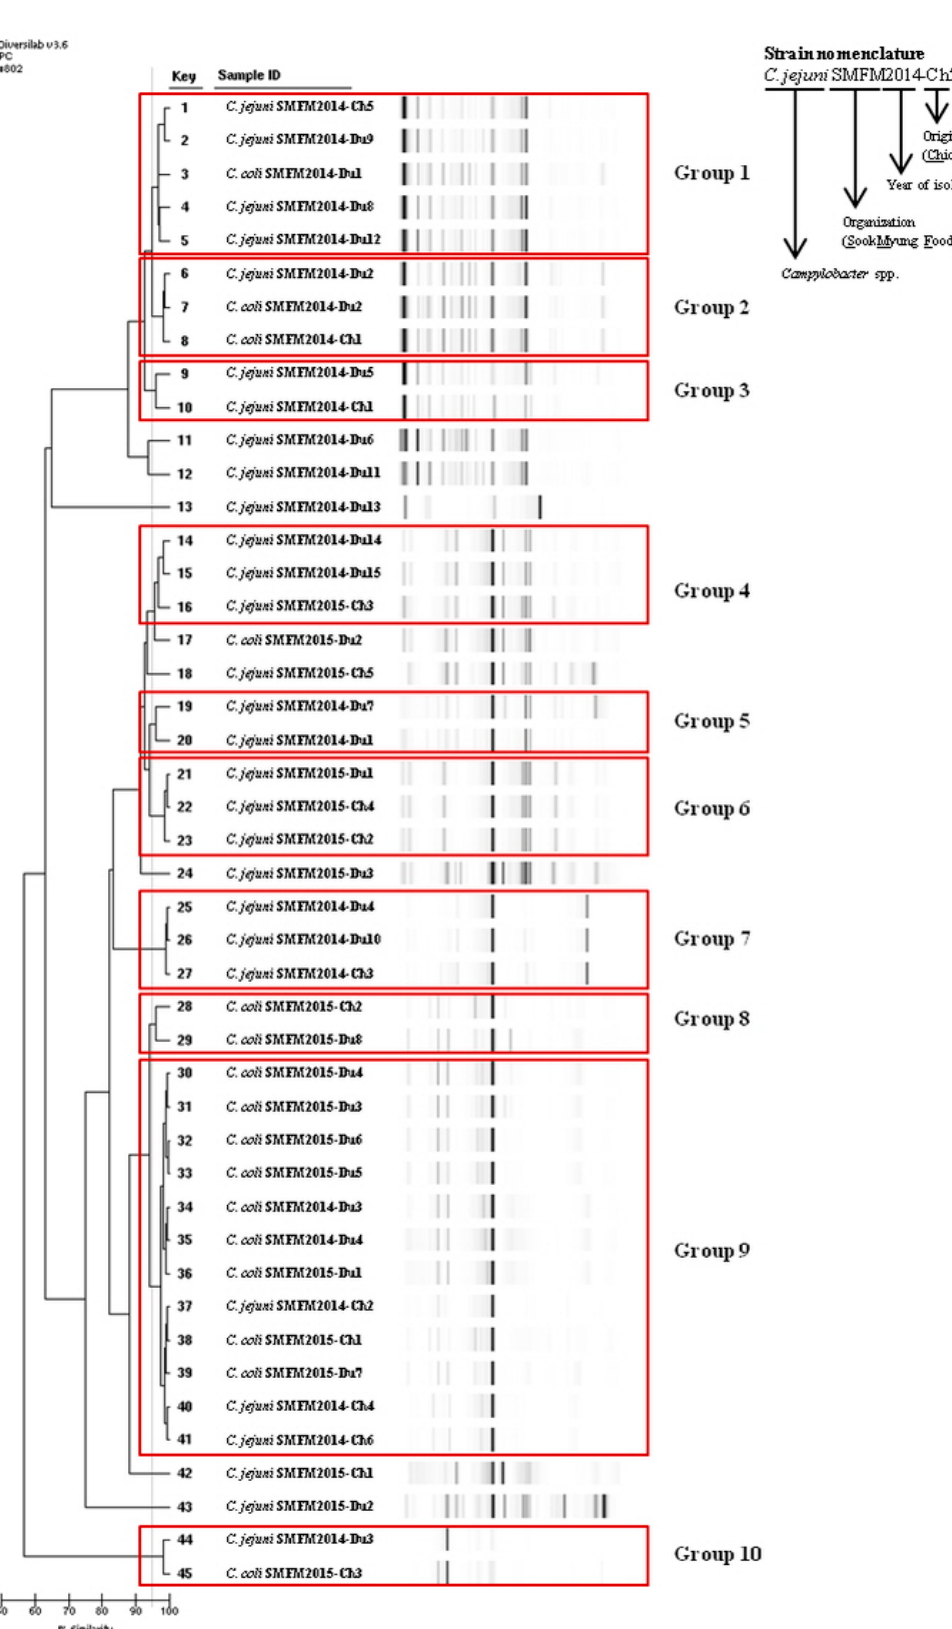
Figure 2. Dendrogram and gel ‐ like image of the DiversiLab systems for Campylobacter isolates from poultry samples.